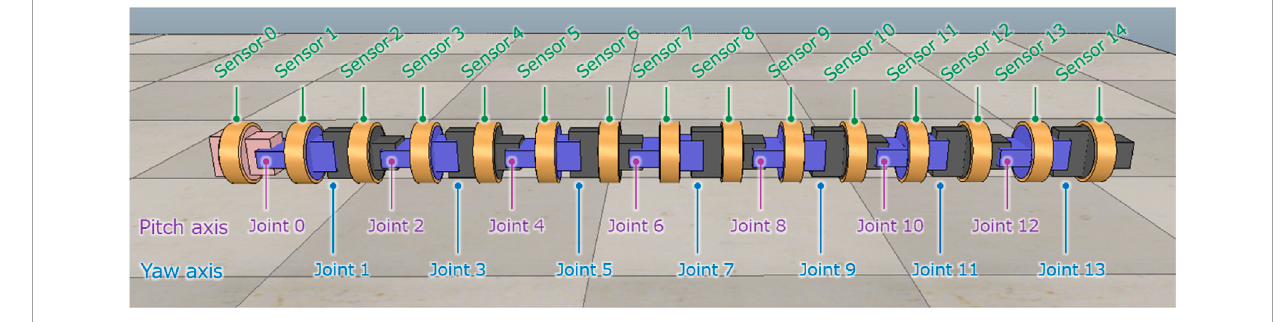
FIGURE 1 Simulation model of the snake robot.